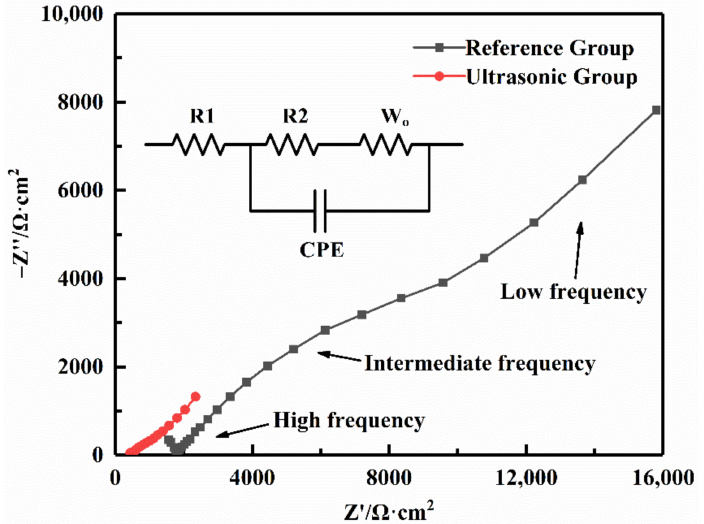
Figure 2. AC impedance spectroscopy of the cathode symmetric